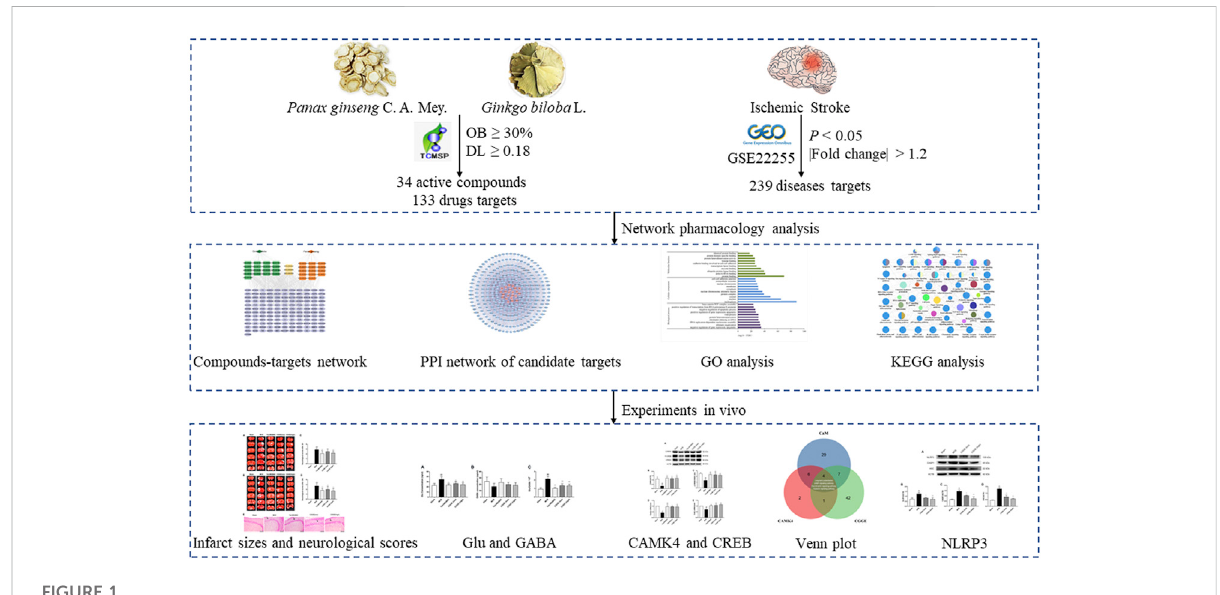
FIGURE 1 The work fl ow of the